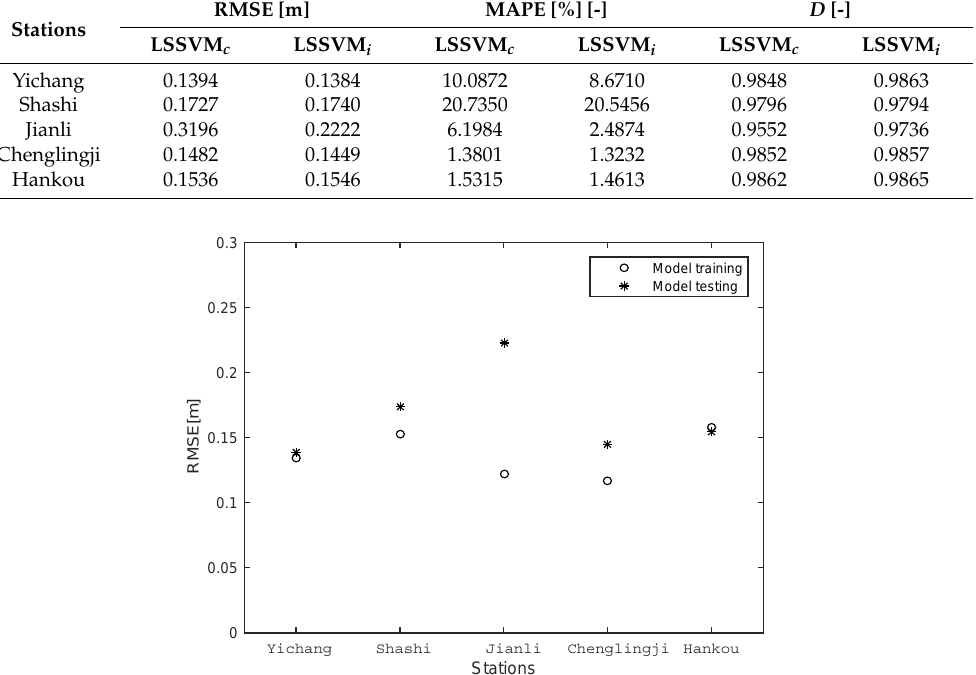
Table 3 . Computations of qualified rate R q by using LSSVM i and LSSVM c.